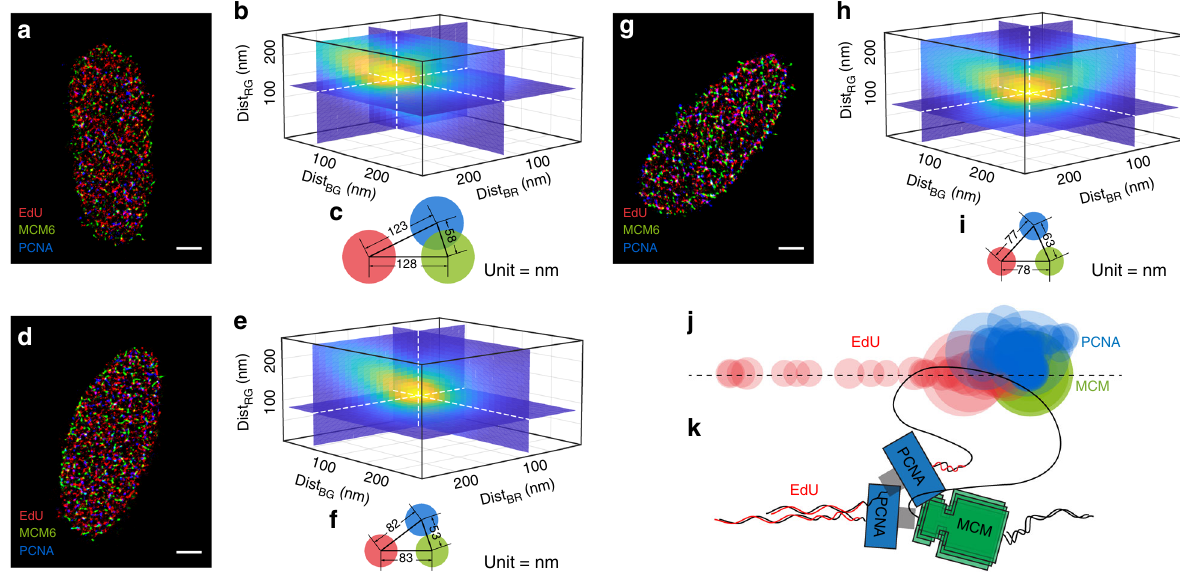
Fig. 3 Validation of the dTC algorithm on experimental SMLM data. a A representative U2OS nucleus labeled with EdU (R), PCNA (B), and MCM (G). The intrinsic con fi guration amongst RGB is barely seen by eye due to the highly dense complexity. b , c Triple-Correlation ( b ) and its reconstructed EdU- PCNA-MCM con fi guration ( c ) of the nucleus in a . d – i Two other representative U2OS nuclei ( d , g ) and their triple-correlation pro fi le. Scale bar = 2500 nm in a , d , g . j Con fi gurations resolved from N = 86 nucleus in total from 3 experimental replicates are fi ltered by the criteria Dist_BG (distance between PCNA and MCM) ≤ 100 nm and overlaid by aligning the RG edge onto the same horizontal, so that the relative distribution of PCNA (B) to EdU (R) and MCM (G) is clearly seen to form an EdU-PCNA-MCM sequential pattern. The circle size of at each vertex displays the triple-correlation amplitude. k A molecular model of the sequential EdU-PCNA-MCM con fi guration. Source data for Fig. 3j are provided as a Source Data fi